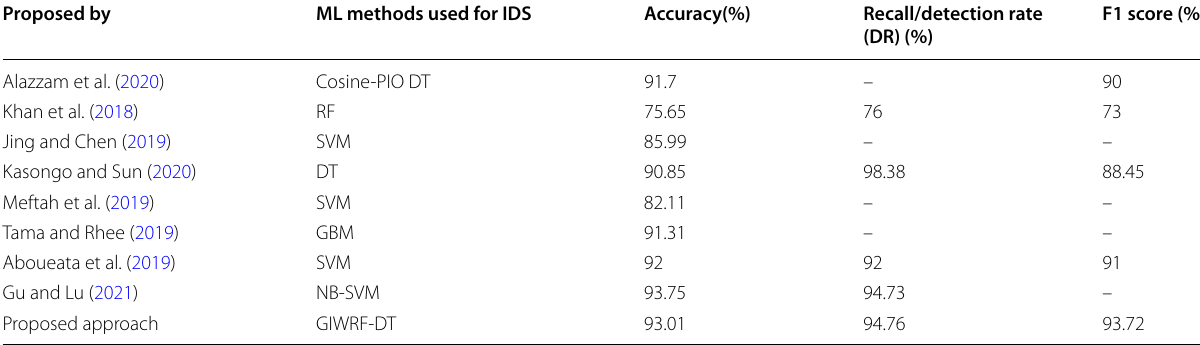
Table 9 Comparison between different existing methods and our proposed approach for UNSW-NB 15 Proposed by